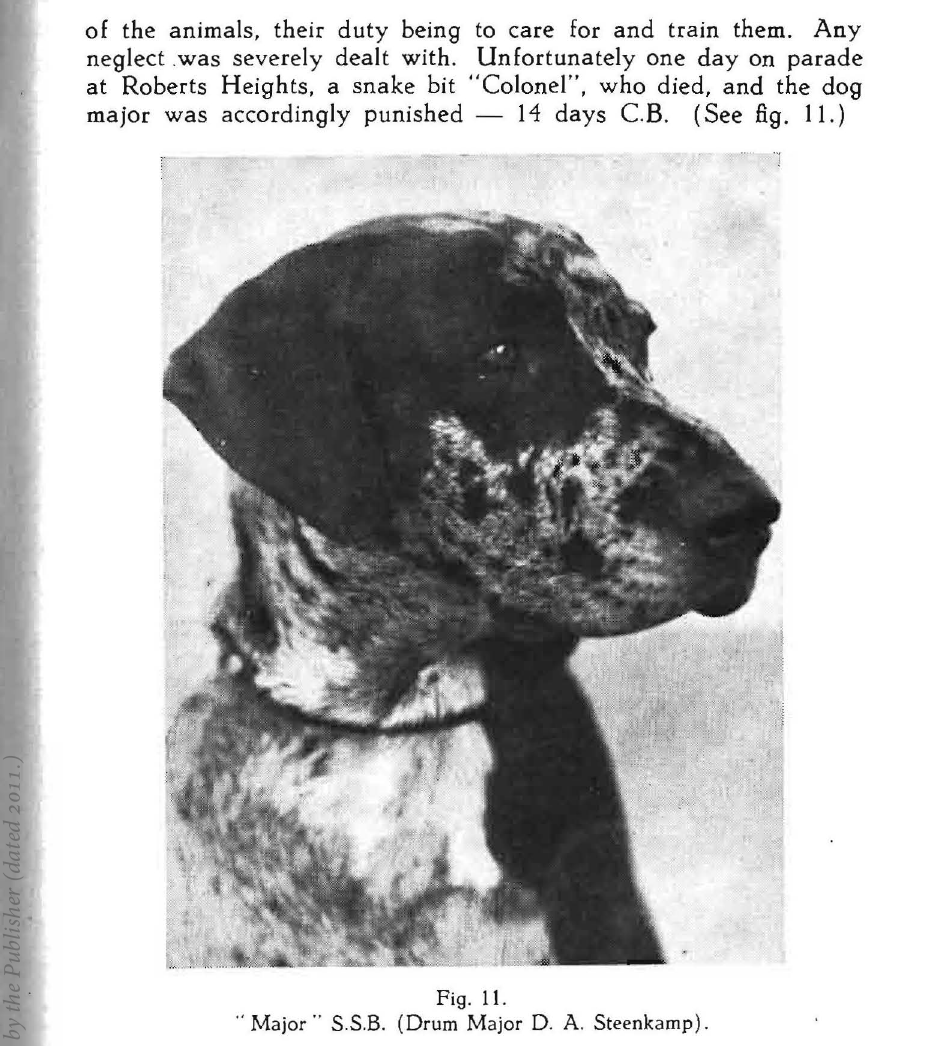
Fig. 11. .. Major " S.S.B. (Drum Major D. A. Steenkamp)